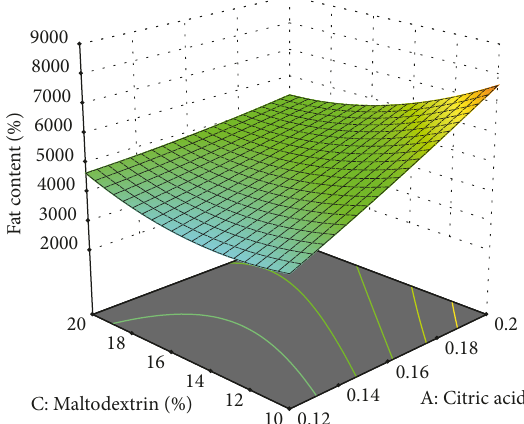
Figure 4: Fat content of cheese analogue was affected by concentra- tion of citric acid and